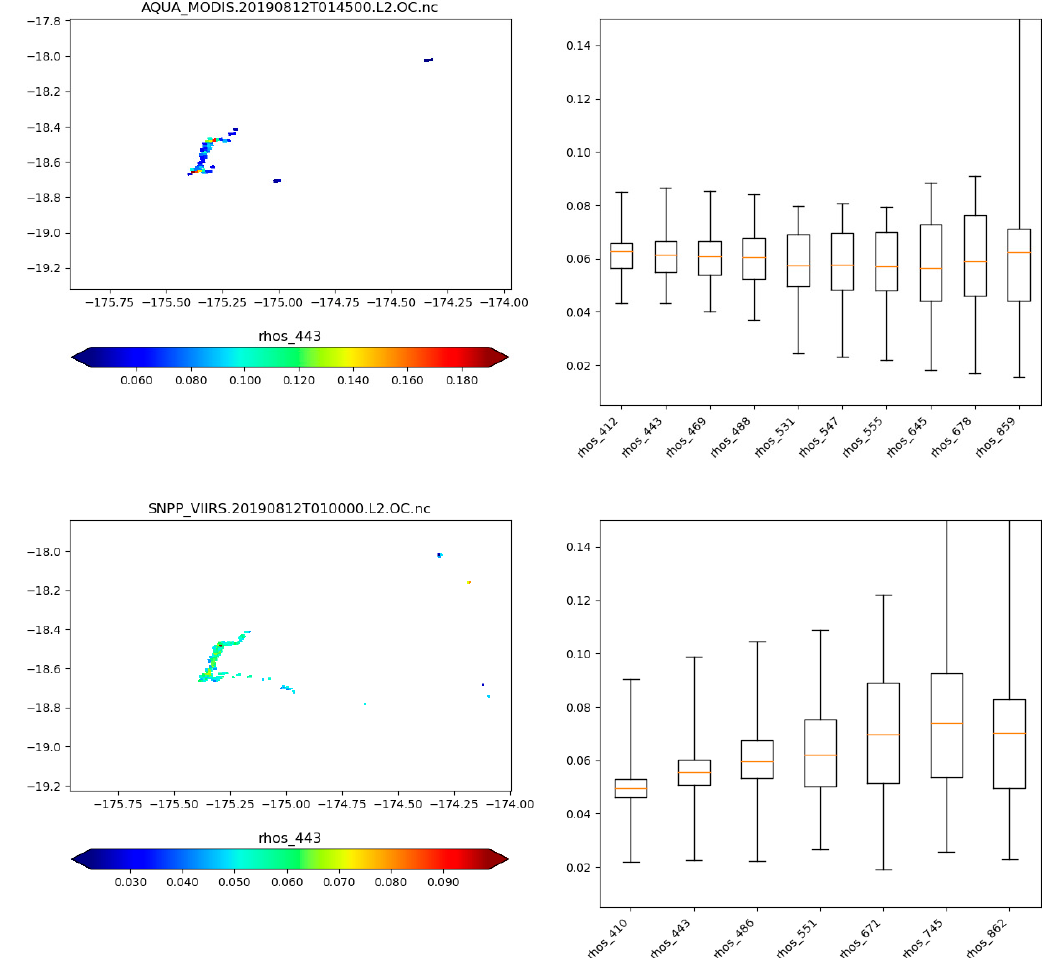
Figure 1. Left: Satellite ρ (rhos) reflectance data at 443 nm under the sea surface temperature (SST) mask of consolidated pumice for 12 August Coordinated Universal Time (UTC) from a threshold in Level 2 (L2) SST Moderate Resolution Imaging Spectroradiometer (MODIS) (top) and Visible Infrared Imaging Radiometer Suite (VIIRS) (bottom) data. Right: Satellite ρ (rhos) data of MODIS and VIIRS at different wavelengths under the “consolidated pumice raft”. Corresponding ρ , as shown by boxplots of pixels under the bb p _giop mask, shows very high values in the UV-blue to blue (410 nm, 443 nm, 486 nm) channels for MODIS as well as for VIIRS (Figure 2). When OC3 (a 3-band bio-optical algorithm for the retrieval of Chla) is used, the disproportion of the blue channel versus the green one creates lower